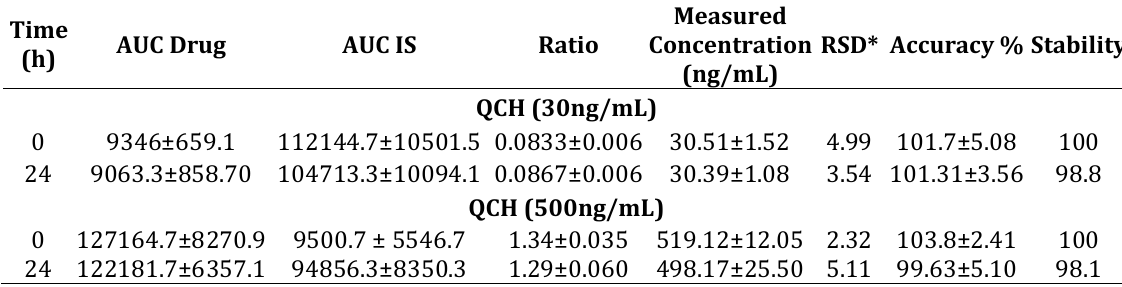
Table 4: Montelukast QC samples stability room temperature (Bench stability); QCL (30ng/mL) and QCH (500ng/mL).